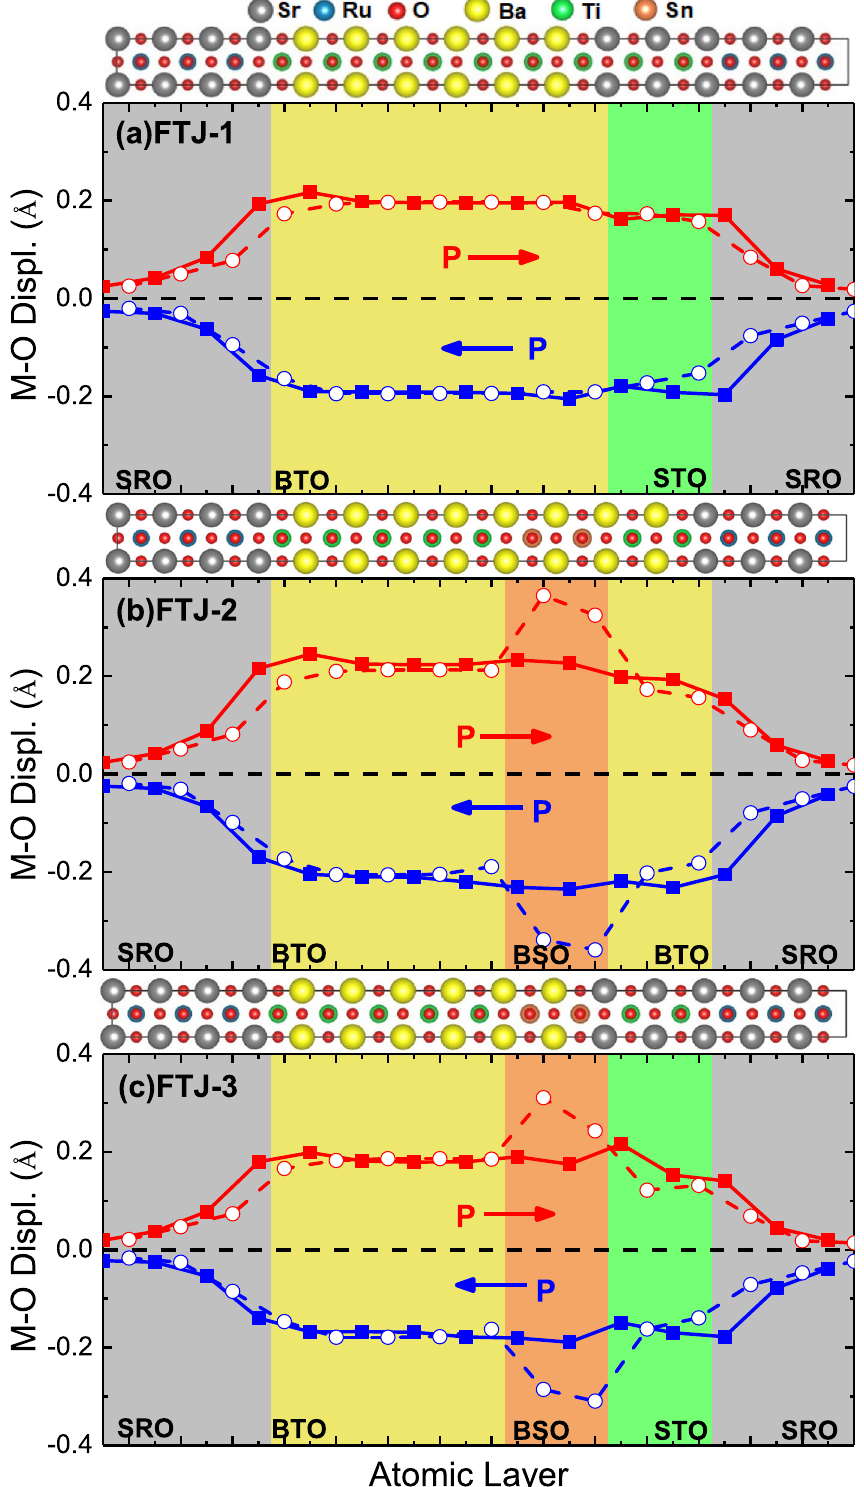
Fig. 1 Calculated relative polar displacement between cation (M) and anion (O) on each AO (A = Ba or Sr) and BO 2 (B = Ti, Sn or Ru) layers. a FTJ-1: SRO/BTO/STO/SRO, b FTJ-2: SRO/BTO/BSO/SRO, and c FTJ-3: SRO/BTO/BSO/STO/SRO. Positive (negative) values of the displacement shown in red (blue) correspond to polarization pointing to the right (left). Open and solid symbols denote Ti – O, Sn – O, Ru – O, and Ba – O, Sr – O displacements,